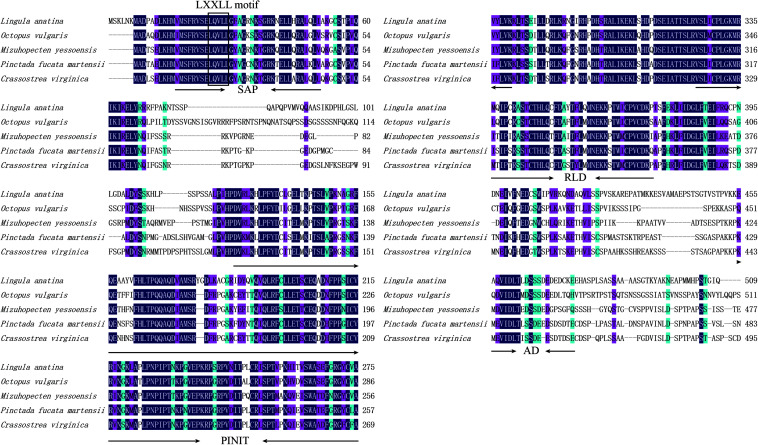
Multiple-sequence alignment and structural organization of PmPIAS aa sequences. Dark blue background indicates conserved aa, pink background indicates aa with strong similarity, light blue indicates aa with weak similarity, and the numbers on the right show the position of sequence alignment. The frame showed the conserved motif (LXXLL). The accession numbers for sequences used in this alignment and structure analysis are as follows: Crassostrea virginica (XP_022331287.1), Mizuhopecten yessoensis (XP_021340266.1), Octopus vulgaris (XP_029634642.1), and Lingula anatina (XP_013385044.1).